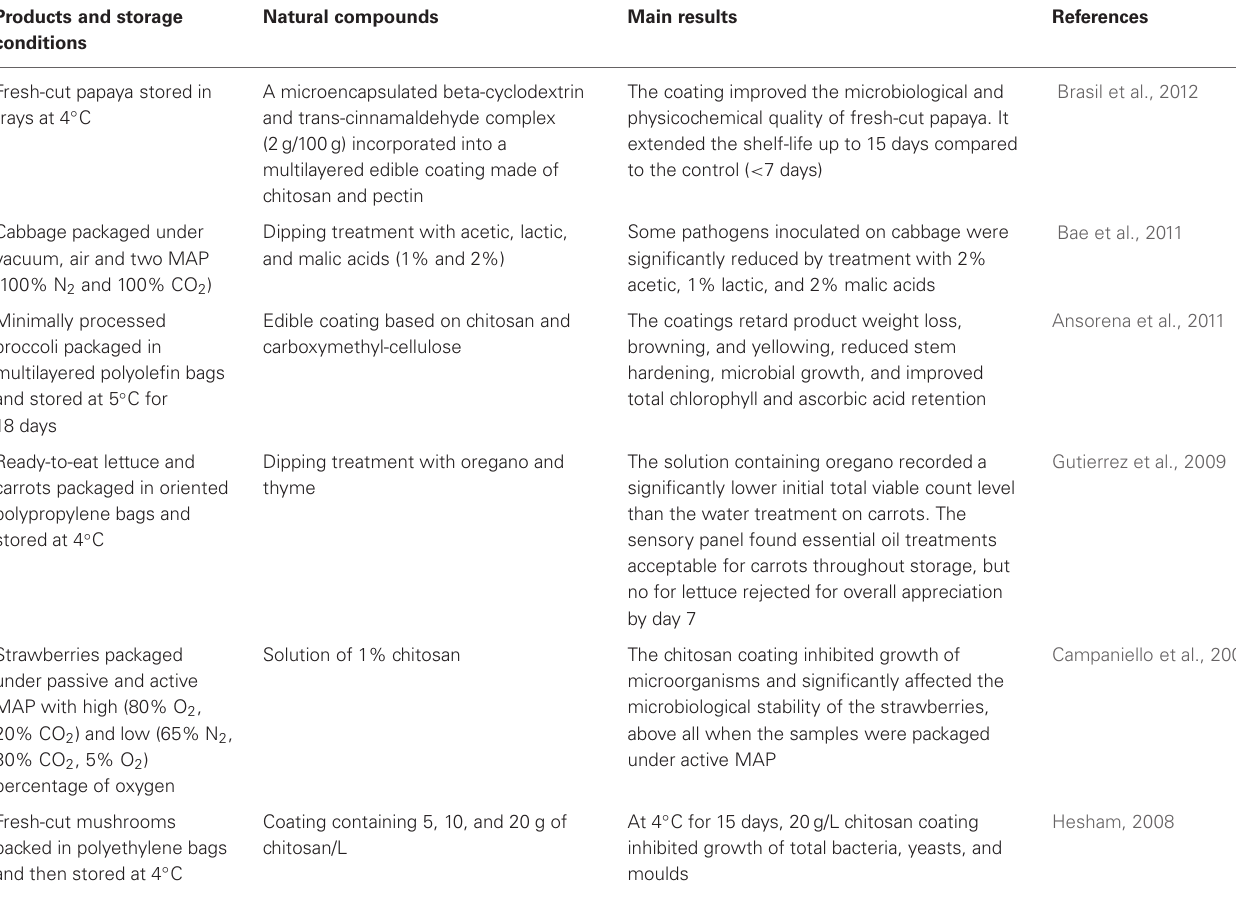
Table 1 | Relevant examples of natural active agents applied to minimally processed